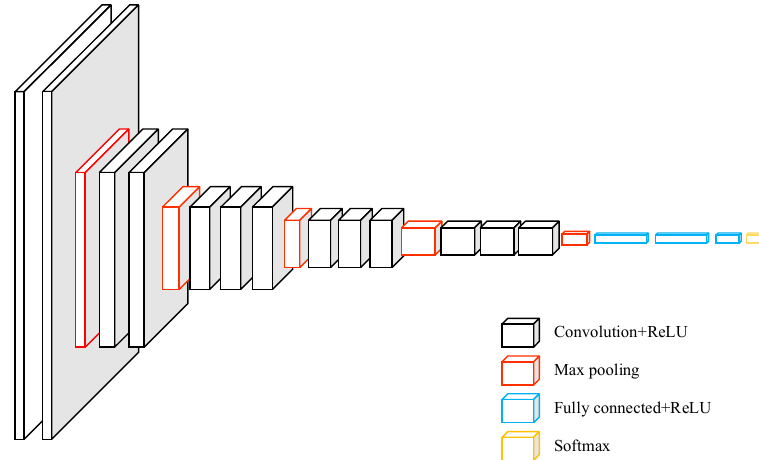
Figure 7. Basic structure of VGG.